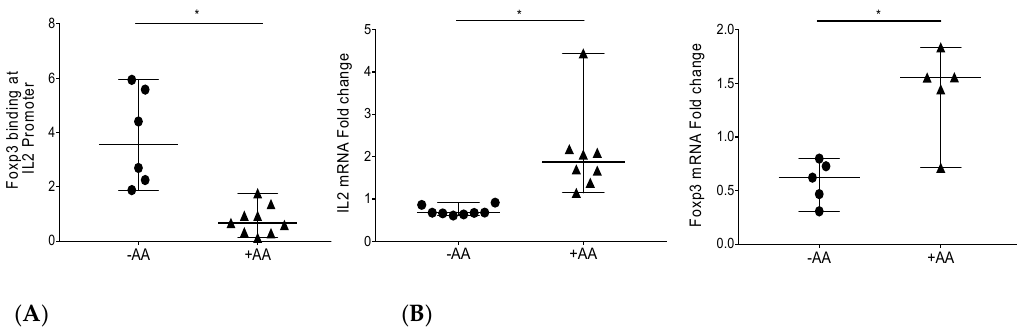
Figure 2. Anacardic acid blocks endogenous Foxp3 binding to the IL-2 promoter and increases IL-2 mRNA levels in vitro . ( A ) Mya-1 cells were either untreated (circles, n = 6) or treated with 20 μM AA (triangles, n = 9); AA treatment inhibited Foxp3 binding at the IL-2 promoter. ( B ) Mya-1 cells were either untreated (circles) or treated with 20 μM AA (triangles) and assessed by RT-qPCR. Both IL-2 mRNA ( n = 8) and forkhead box P3 (Foxp3) mRNA ( n = 5) were increased following AA treatment. All data are presented as the median with range, where each point represents an individual experiment. Statistical differences were determined by Mann-Whitney test, with * representing p < 0.05.